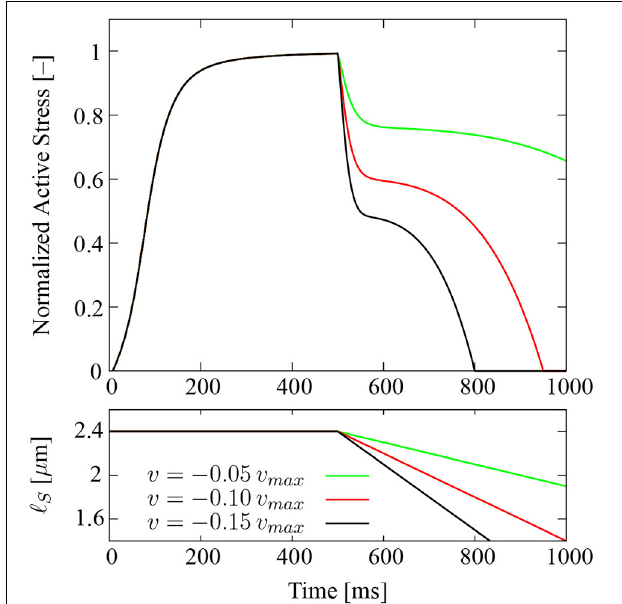
FIGURE 5 | Evolution of the normalized sarcomere-based active stress of an isolated half-sarcomere model for three different shortening velocities at a stimulation frequency of 100Hz (top). The shortening contraction is preceded by an isometric contraction at optimal length of 500ms duration. Additionally, the actual sarcomere length ( (cid:2) S ) is shown for each of the stress profiles (bottom).